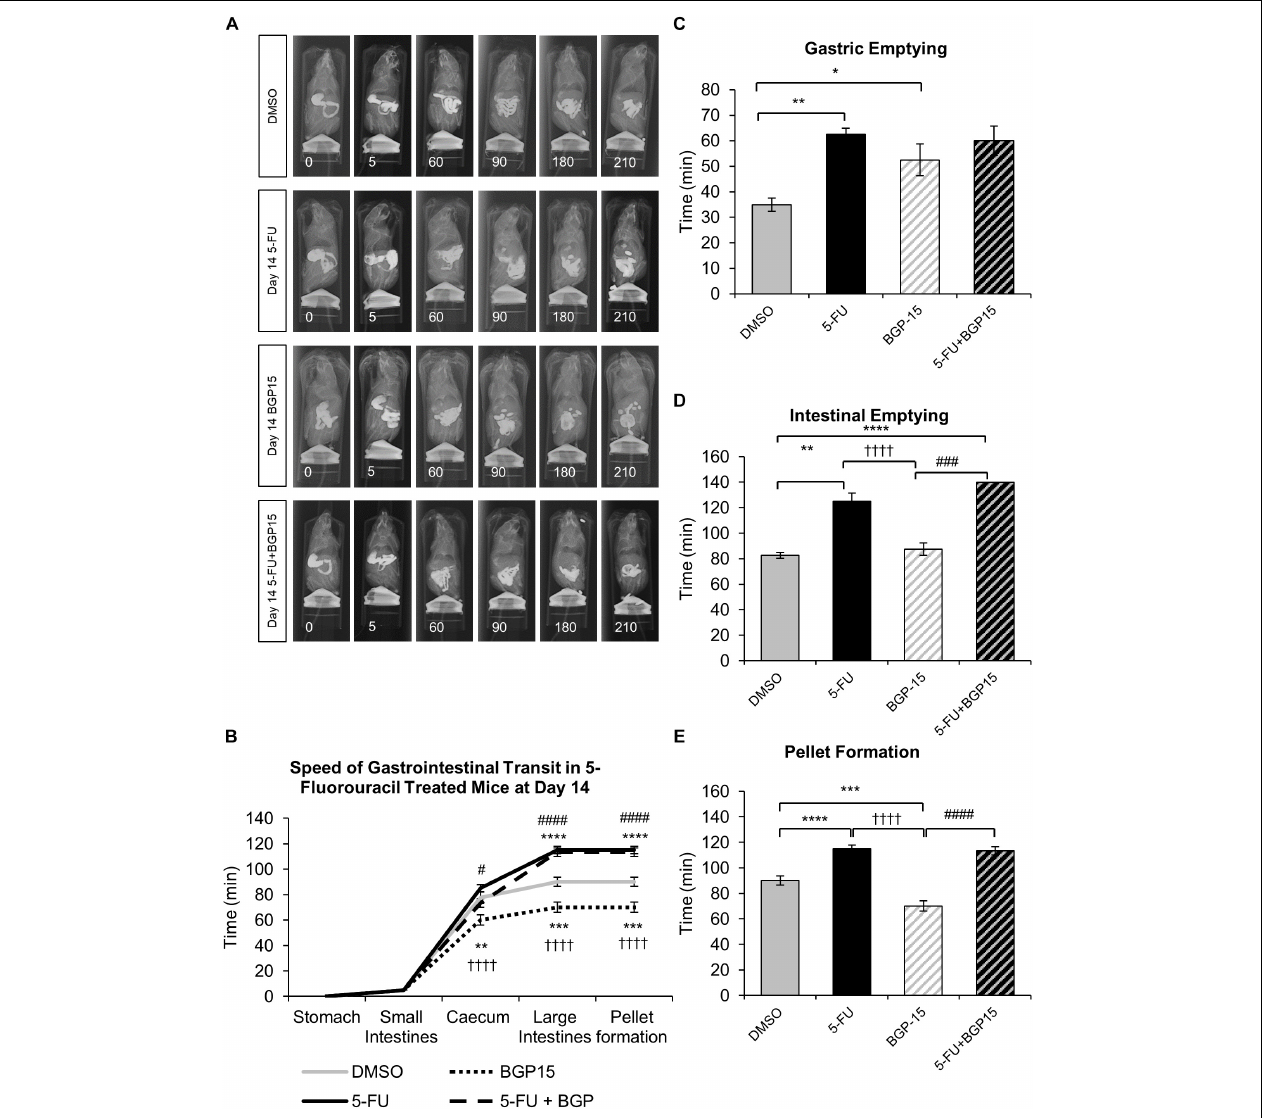
FIGURE 1 | Gastrointestinal transit time, gastric, and intestinal emptying following repeated in vivo 5-FU ± BGP-15 administration at day 14. Representative X-ray images obtained from mice 5–210 min after intragastric barium sulfate (0.4 mL and 2.5 mg/mL) following 14 days of DMSO, 5-FU, BGP-15, and 5-FU+BGP-15 administration (A) . Time (min) taken for barium sulfate to reach the stomach, small intestines, caecum, and large intestines at 7 days following DMSO, 5-FU, BGP-15, and 5-FU+BGP-15 administration (B) . Time (min) taken for complete emptying of barium from the stomach (C) . Time (min) taken for complete emptying of barium from the small intestines (D) . Time (min) taken to form first pellet at 14 days following DMSO, 5-FU, BGP-15, and 5-FU+BGP-15 administration (E) . Data represented as mean ± SEM. ∗ P < 0.05, ∗∗ P < 0.01, ∗∗∗ P < 0.001, ∗∗∗∗ P < 0.0001 significantly different to DMSO. †††† P < 0.0001 significantly different to 5-FU. # P < 0.05, ### P < 0.001, #### P < 0.0001 significantly different to BGP-15 ( n = 5 mice/group).